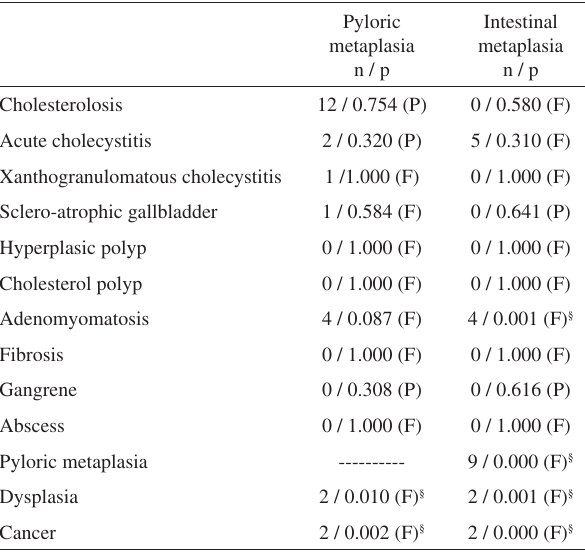
Table 5 - Analysis of gallbladder histological alterations and metaplastic alterations